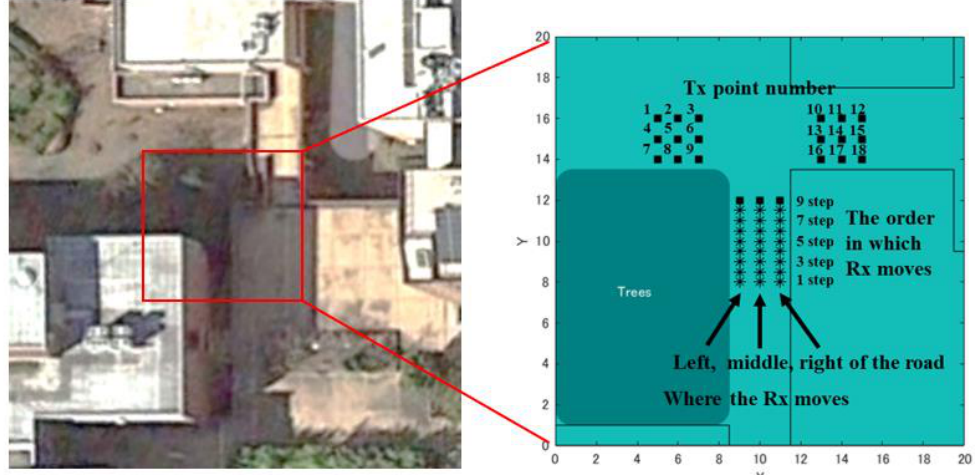
Figure 10. View of T-shaped road, and the setting of Rx movements and Tx positions.